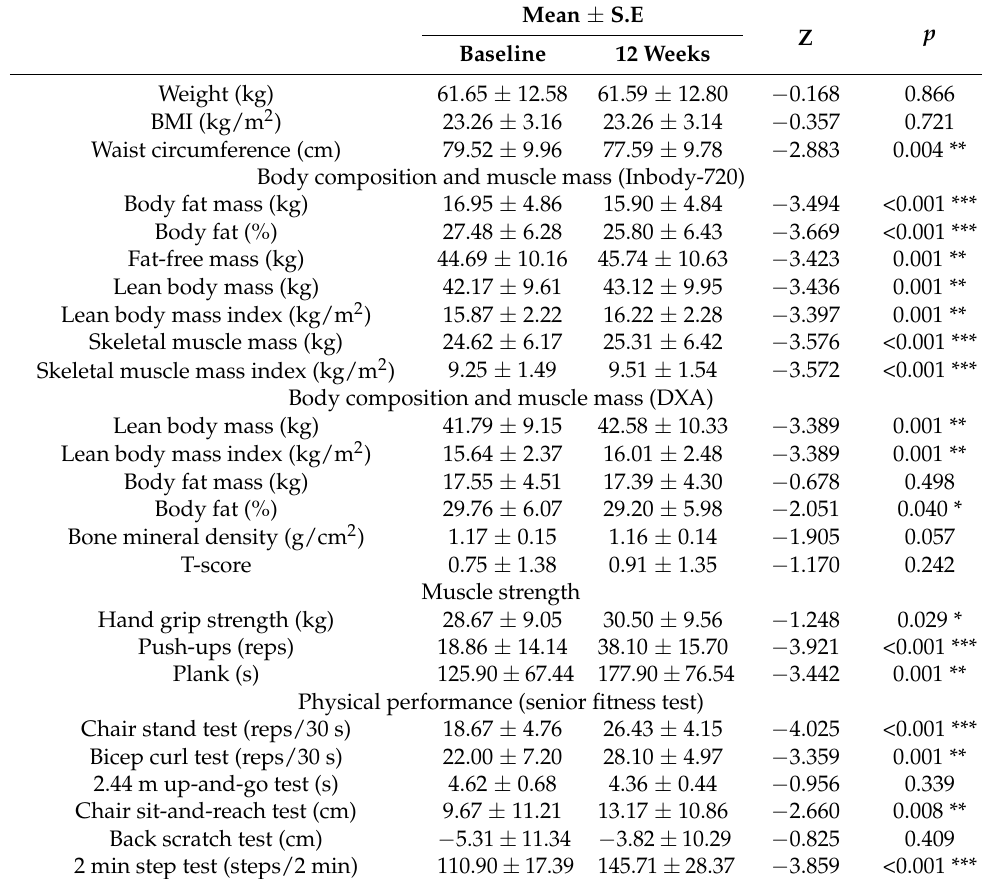
Table 7. Changes within the intervention group ( n = 21) during the 12-week study